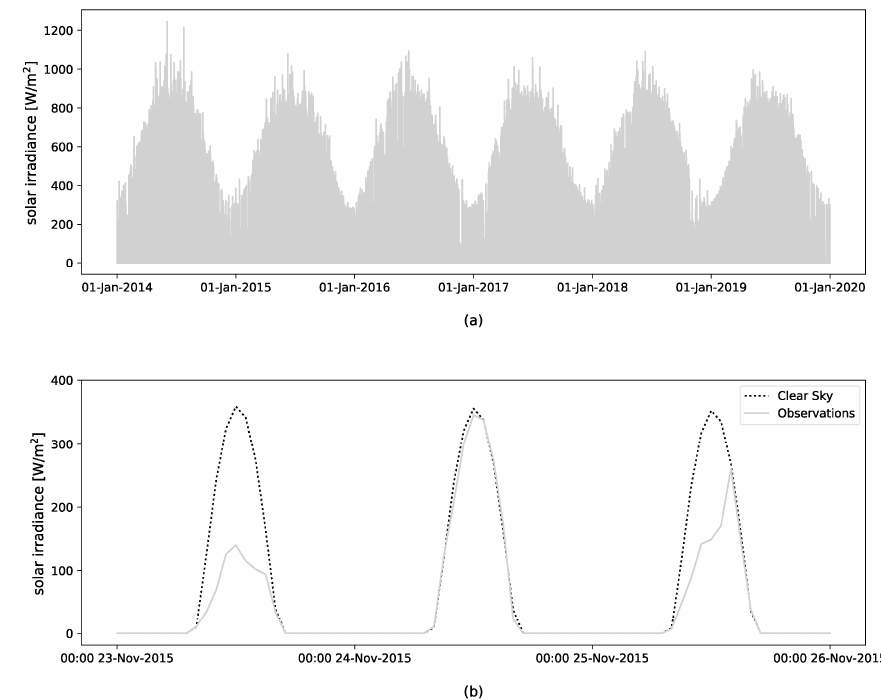
Figure 1. Hourly solar irradiance time series ( a ), compared with clear sky values for a few specific days ( b